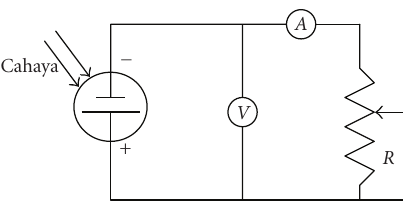
Figure 5: The circuit for the measurement of photocurrent- photovoltage characterization of DSSC using black rice adsorbed on a nanocrystalline TiO 2 film electrode with 35W HID lamp.